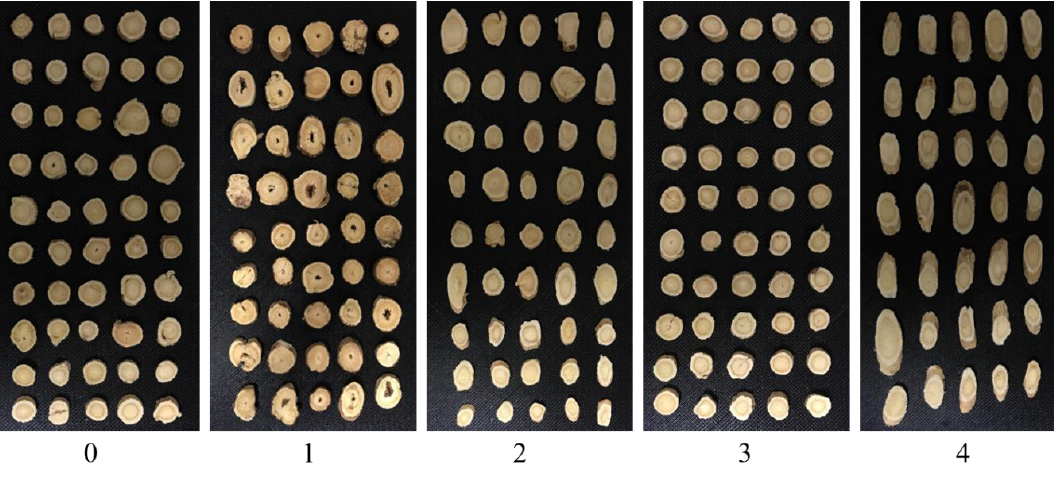
Figure 1. RGB images of Radix Astragali from Gansu province, Heilongjiang province, the Inner Mongolia autonomous region, Shanxi province, and the Xinjiang Uygur autonomous region.